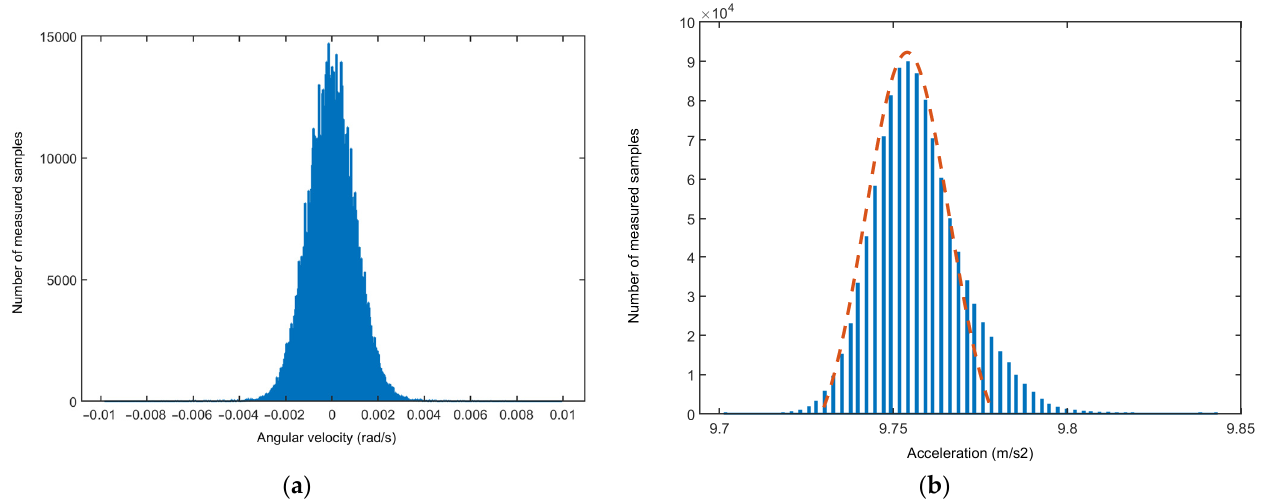
Figure 7. ( a ) The histogram of the x-axis angular velocity measured with the IMU sensor in a smartphone. ( b ) The histogram of the z-axis acceleration measured with the IMU sensor in the same smartphone. The orange dashed curve with normal Gaussian distribution is added for comparison, revealing the skewness of the acceleration data.